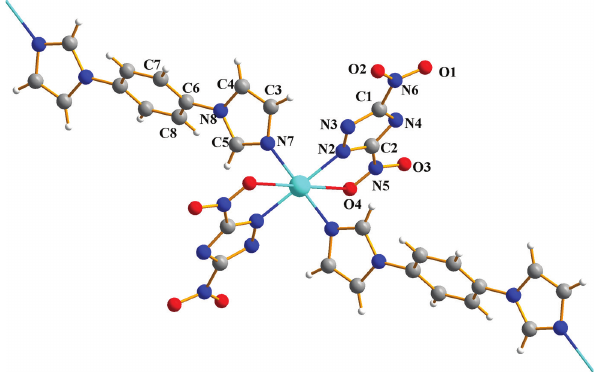
Table 1: Data collection and handling.